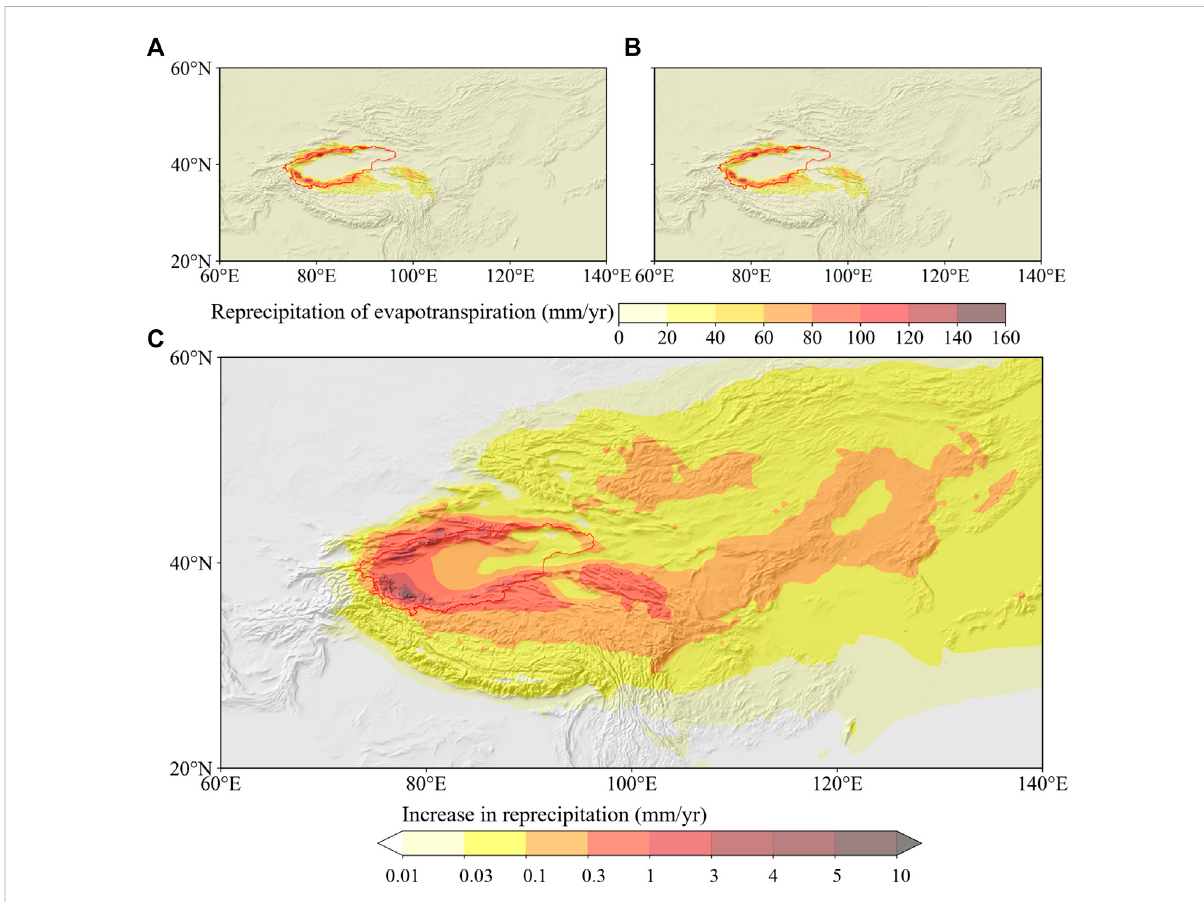
FIGURE 7 SpatialdistributionofreprecipitationintheTarimBasinof (A) thebaselinescenarioand (B) ScenarioII,and (C) thedifferencebetweenScenarioII and the baseline